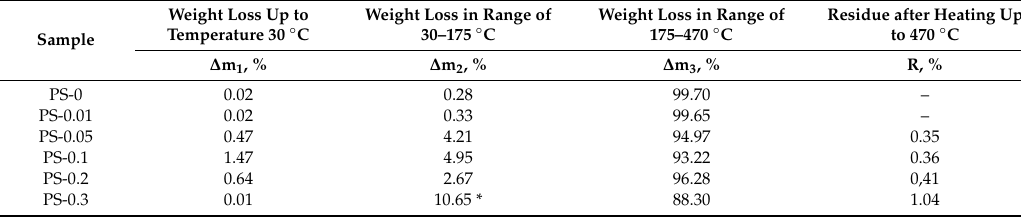
Table 3. Values of weight loss in subsequent thermal transformations of tested samples.